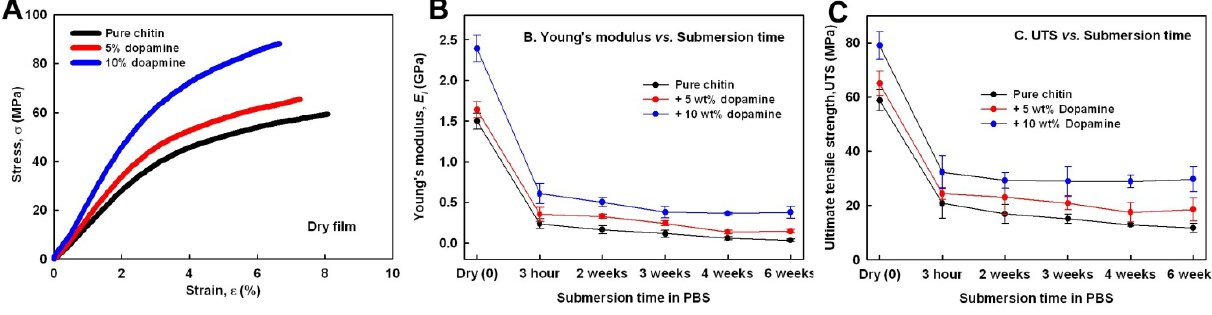
Figure 4. ( A ) Strain-stress curves of pure regenerated chitin (black curve), 5 wt % dopamine-containing composite (red curve) and 10 wt % dopamine-containing composite (blue curve); ( B ) Young’s modulus; and ( C ) ultimate tensile strength (UTS) values of pure regenerated chitin, 5 wt % dopamine-containing composite and 10 wt % dopamine-containing composite depending on submersion time in phosphate-buffered saline